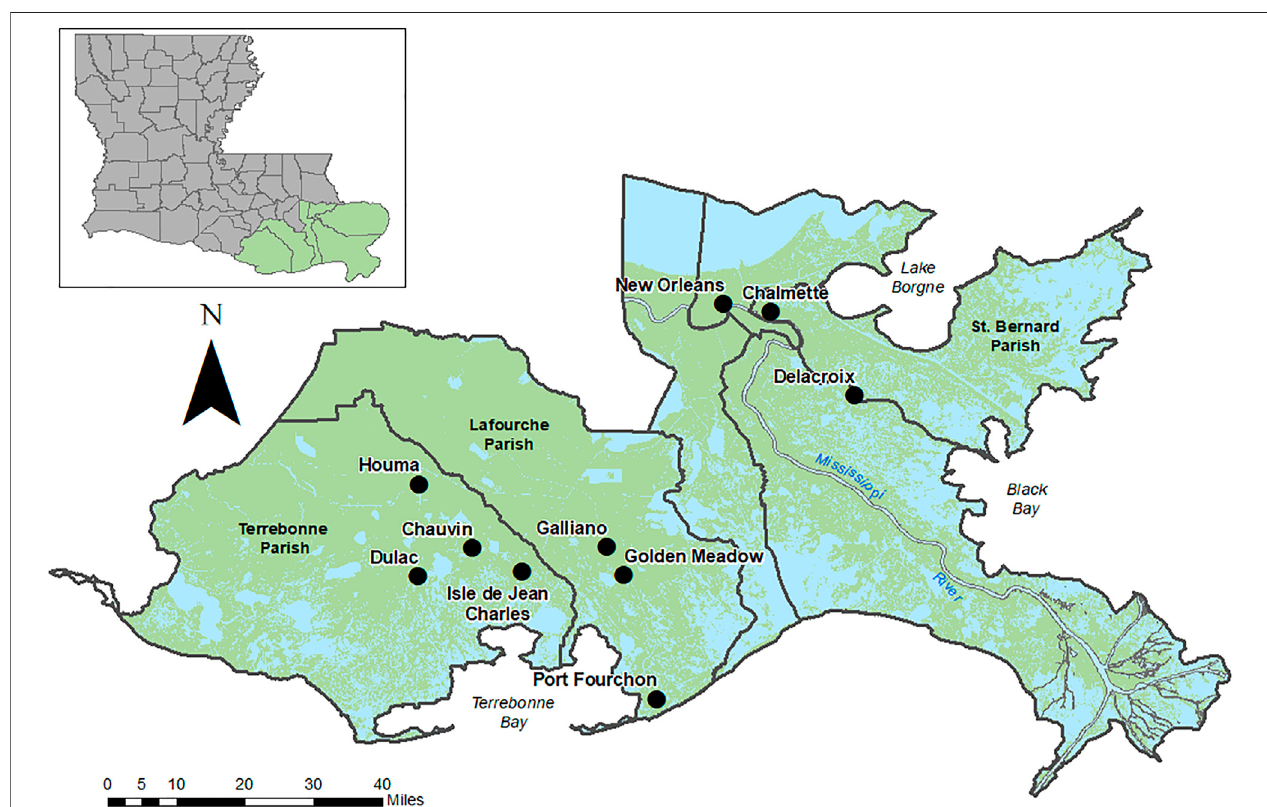
FIGURE 1 | Map of southeast Louisiana showing study parishes and related